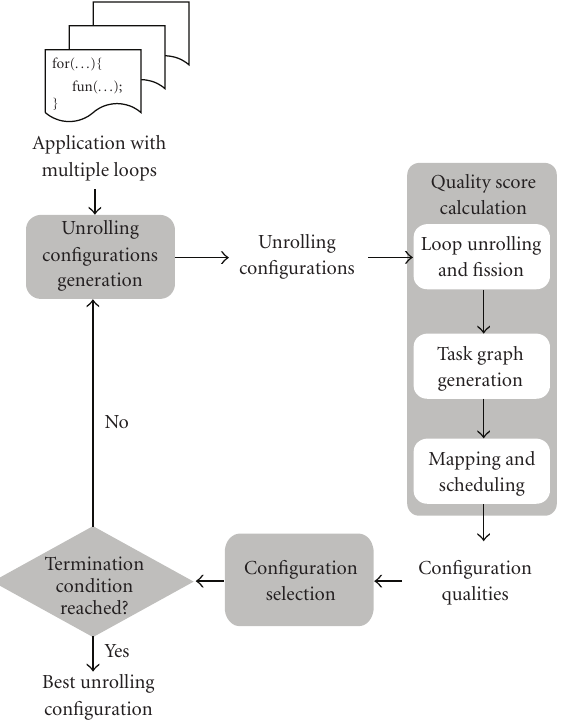
Figure 2: Overview of the proposed multi-loop parallelisation